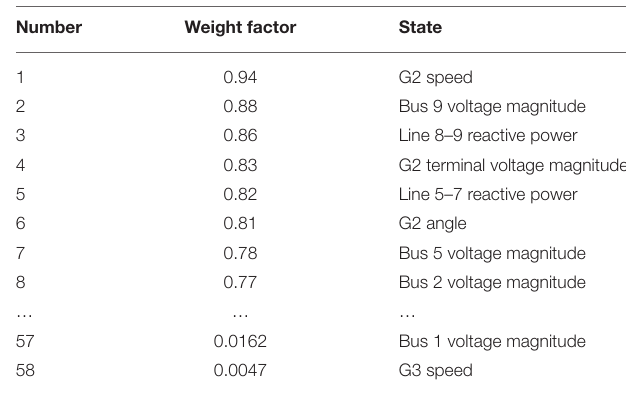
TABLE 3 | Weight factors obtained on 9 bus